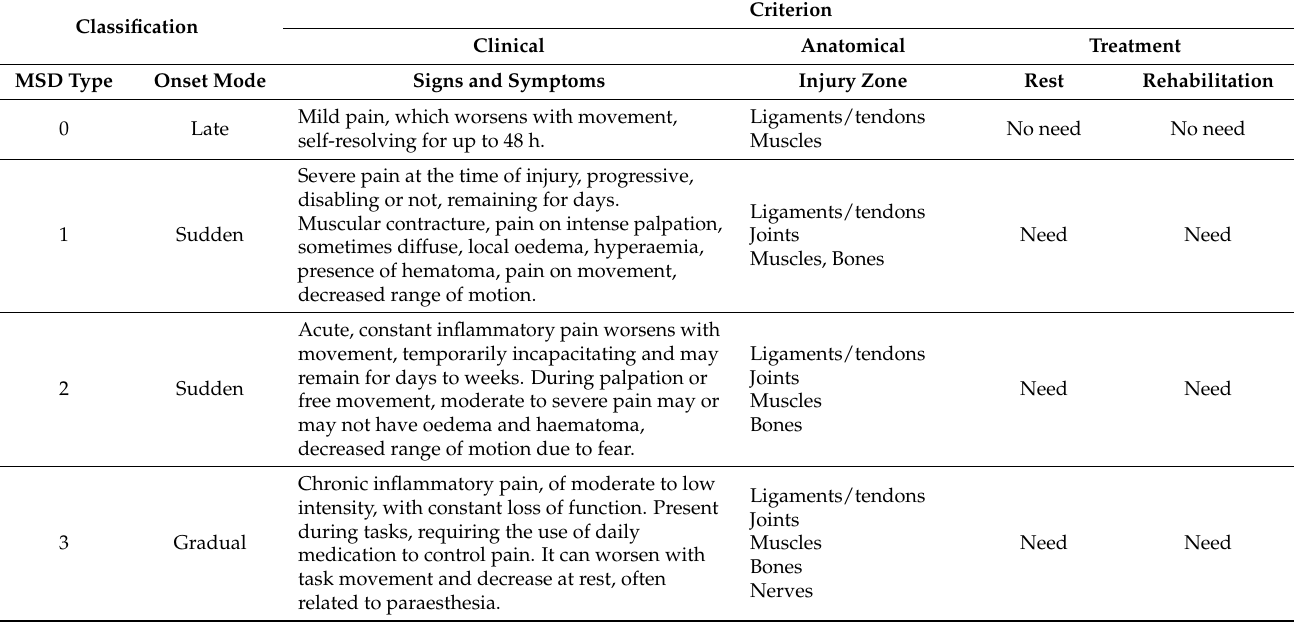
Table 4. Classification according to criteria for defining signs and symptom regeneration